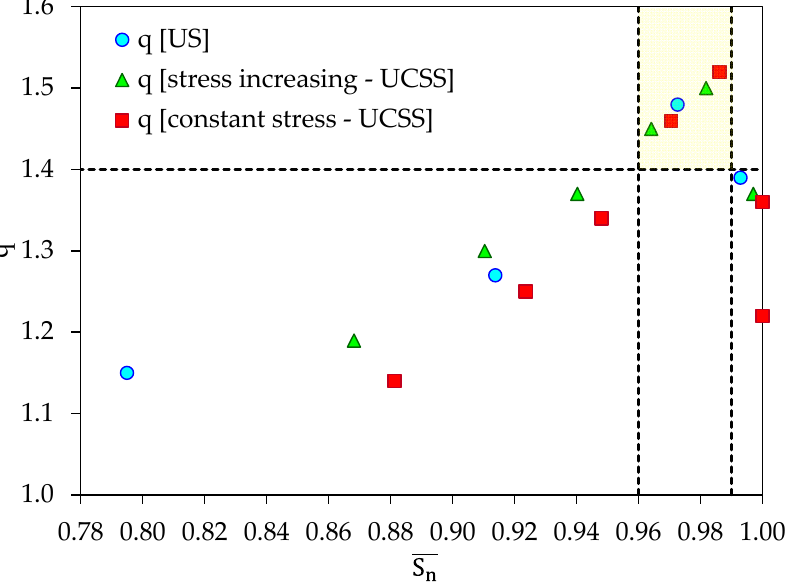
Figure 7. The evolution of the q entropic indices of loading protocols UC (blue circles) and UCSS (green triangles and red squares).